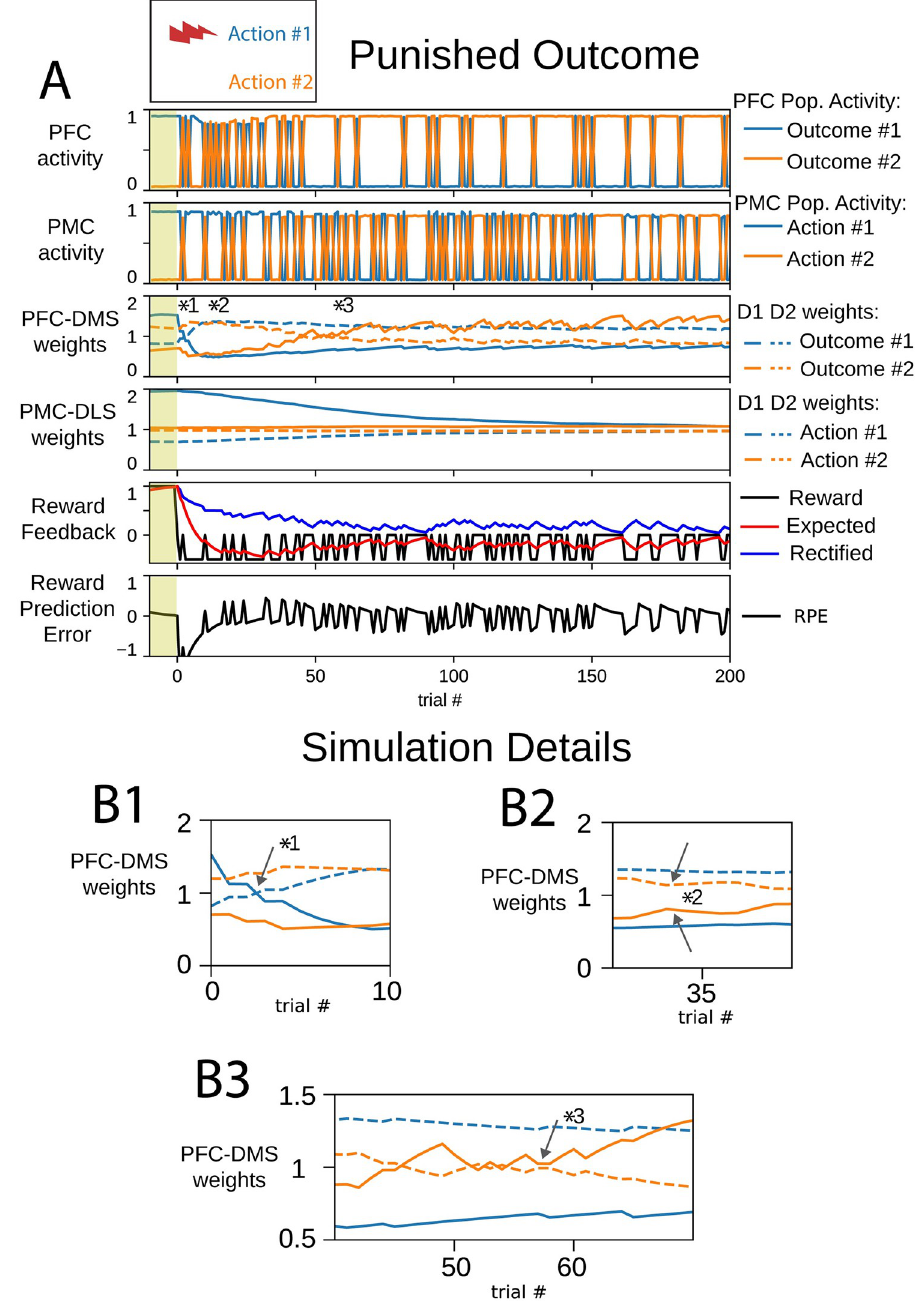
Fig 6. An agent learns to select action #2 in a punished outcome behavioral task. Cortical activity, cortico-striatal synaptic weights, and reward feedback metrics evolve to overcome habit to select action #1. The yellow shaded trials before trial 0 indicate trials at the end of the initial learning session. (A) In panels depicting cortico-striatal weights, D1 synaptic weights are solid traces and D2 synaptic weights are dashed traces. Blue traces correspond to action #1 and orange traces correspond to action #2. (B) Insets correspond to trials indicated by markers 1–3 in part (A). (B1) PFC-DMS cortico-striatal synaptic weights for outcome #1 respond to the negative reward prediction error and evolve to emphasize the indirect pathway. (B2) During exploration, the PFC-DMS channels for both outcomes emphasize the indirect pathway. (B3) In the channel for outcome #2, the direct pathway becomes emphasized to promote the selection of the unpunished